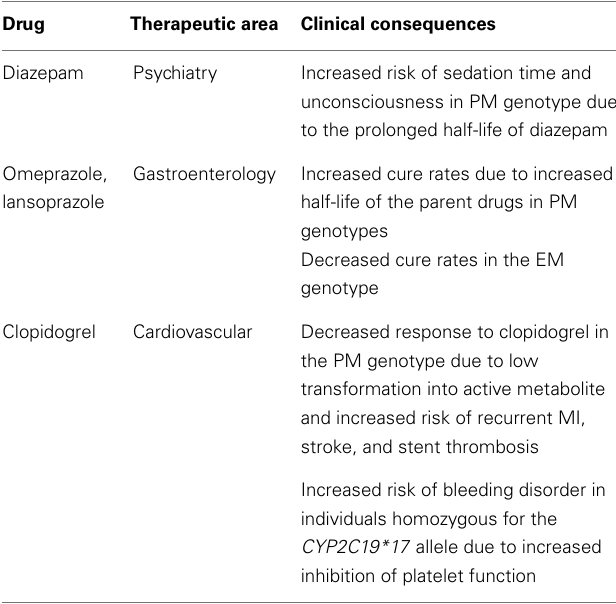
Table 2 | Genetic polymorphisms in CYP2C19 and their clinical